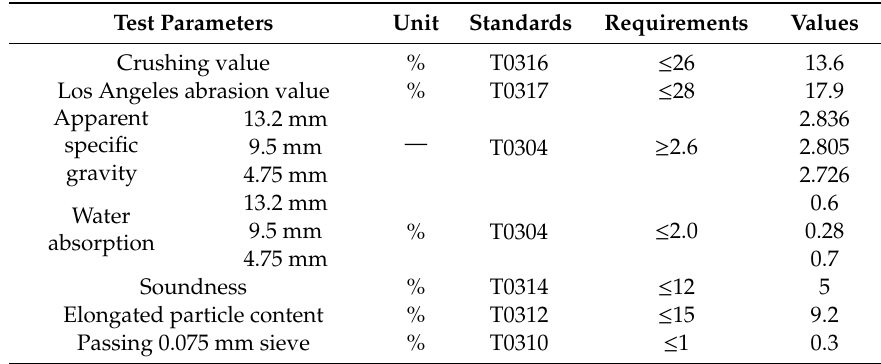
Table 2. Technical properties of basalt coarse aggregates.